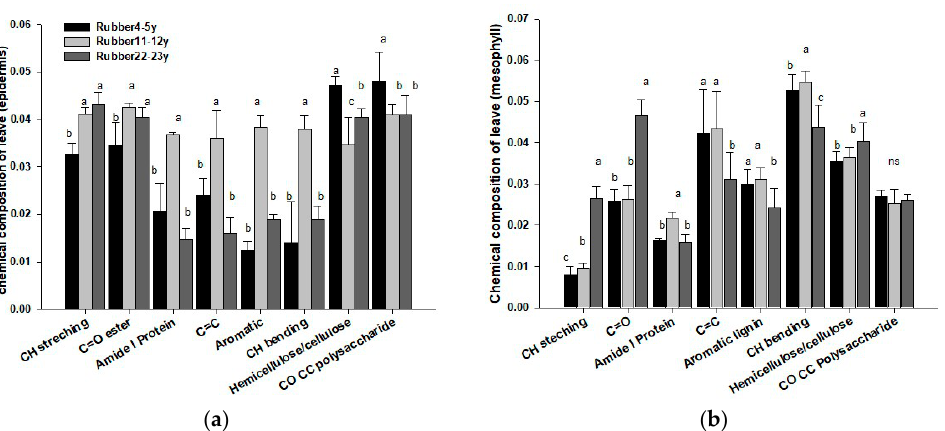
Figure 4. An overlay of second-derivative average spectra from differently aged rubber tree plantations: ( a ) Epidermis and ( b ) mesophyll. The average second derivative spectra were calculated after 13 points of smoothing and normalization, with extended multiplicative signal correlation over the spectral ranges of 3000–2800 and 1800–900 cm − 1 .